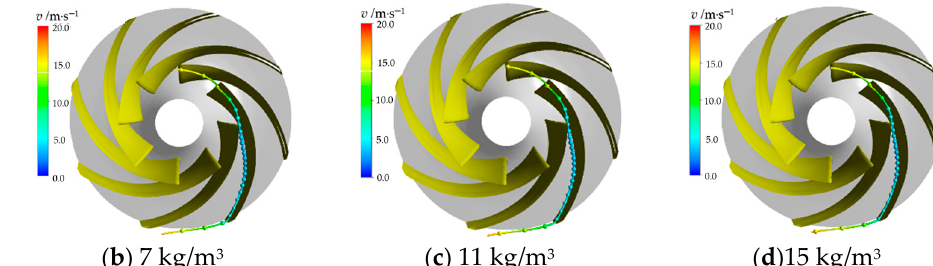
Figure 16. Trajectory of single particle with different particle concentration.